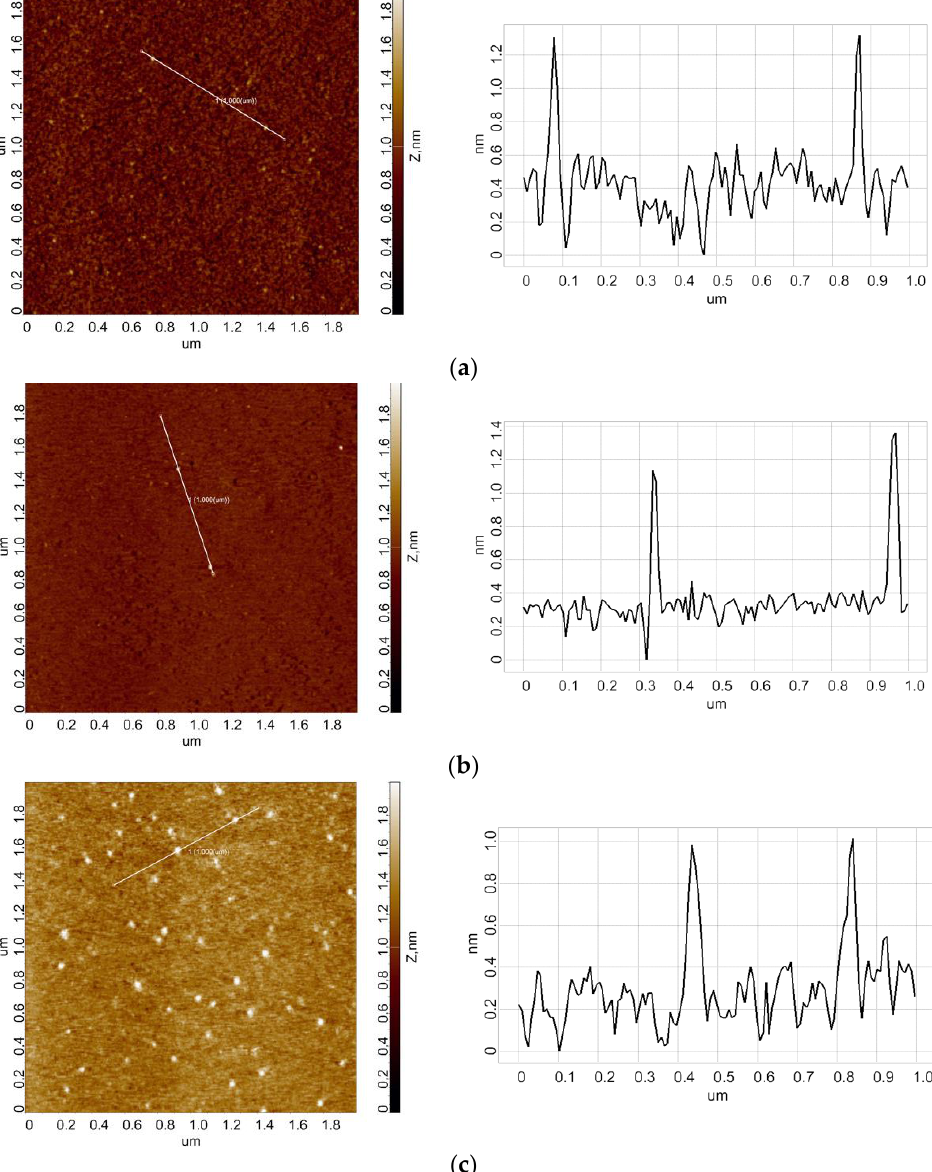
Figure 3. Typical AFM images of mica surface with adsorbed HRP (left) and respective cross-section profiles (right) obtained for HRP solutions incubated either 2 cm above the conical coil ( a ), to the side of the coil ( b ), or 50 m away from the coil (( c ), control experiment). For all AFM images, the scan size is 2 µm × 2 µm, and the Z scale is from 0 to 2 nm.